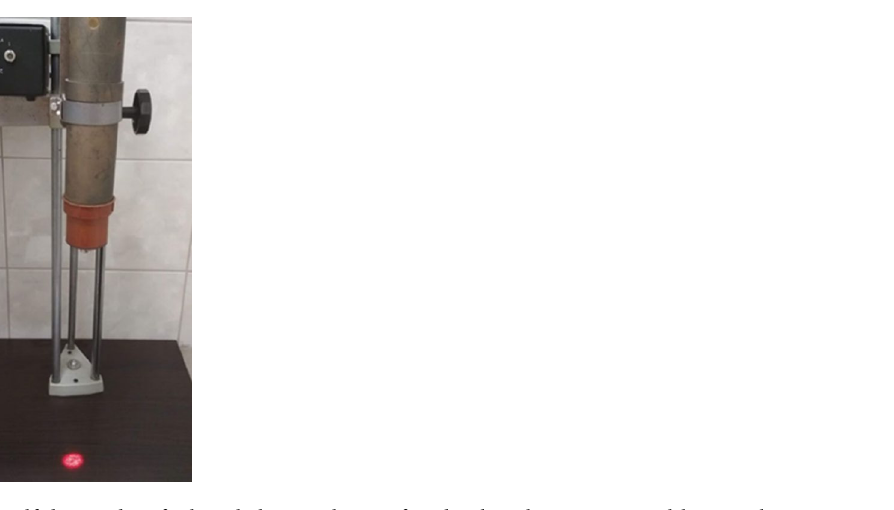
Figure 1. Self-designed rig for laser light stimulation of seeds. Photo by Agata